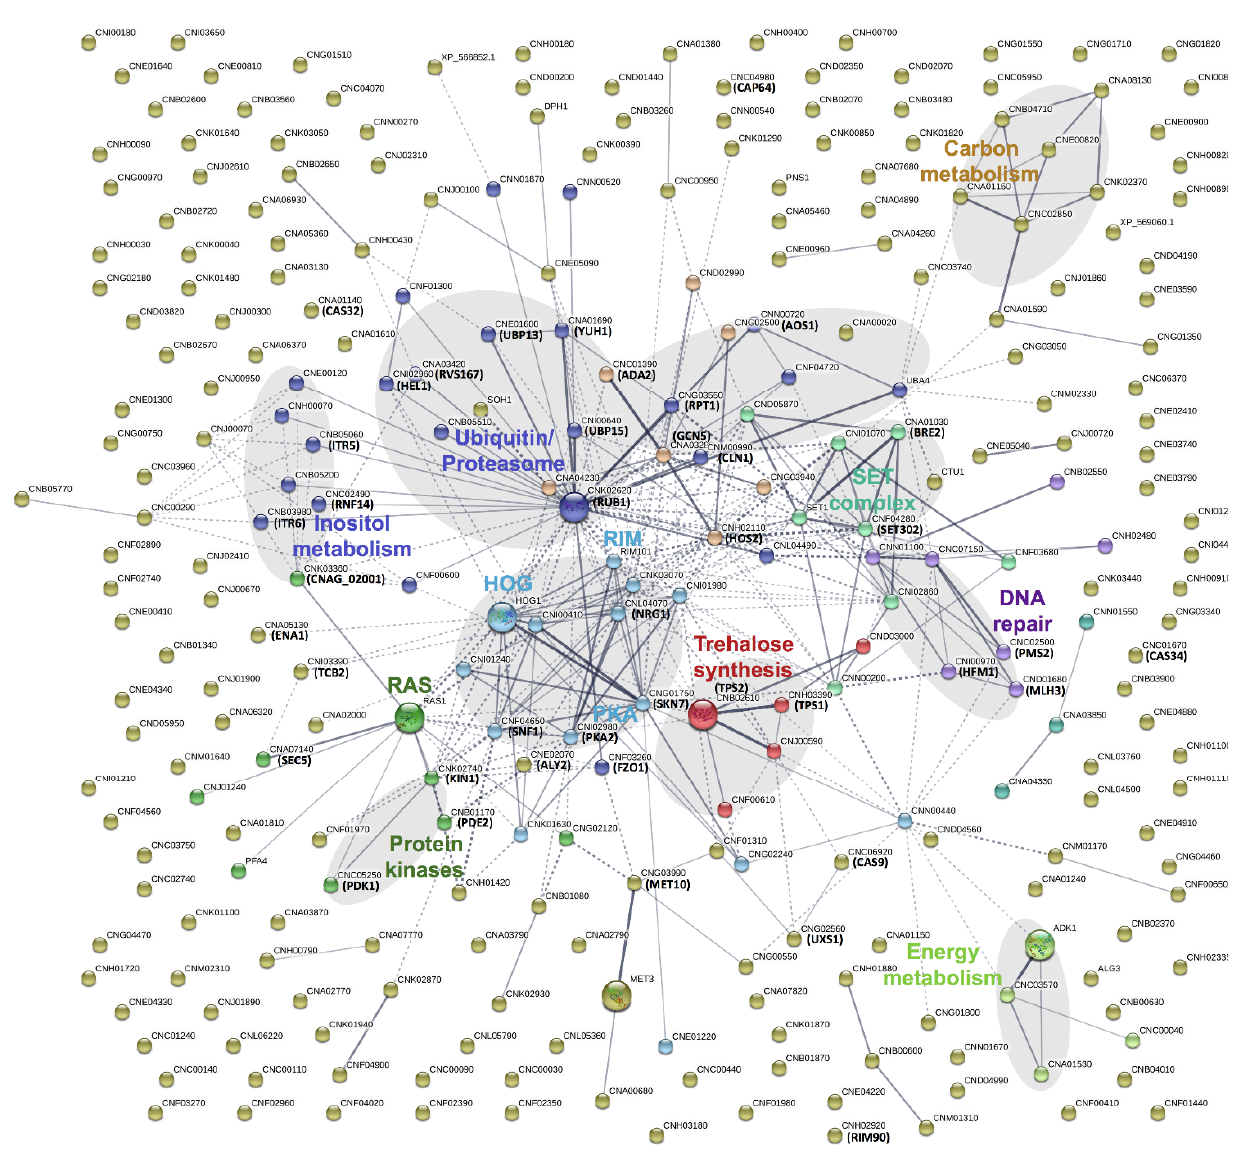
FIGURE 4: A STRING analysis reveals that multiple cellular pathways and activities are regulated by lithium in C. neoformans , including the ubiquitin/proteasome system. The corresponding proteins of the 292 mutants found to be hypersensitive or hypertolerant to lithium were subjected to a STRING analysis using default settings. Network edges are based on confidence with line thickness indicating the strength of data support. Network clusters are color-coded and labeled. Note that the network was built based on data from C. neoformans strain JEC21. In some cases, the corresponding gene names for C. neoformans strain H99 are indicated. HOG, high osmolarity glycerol; PKA, protein kinase A; RAS, rat